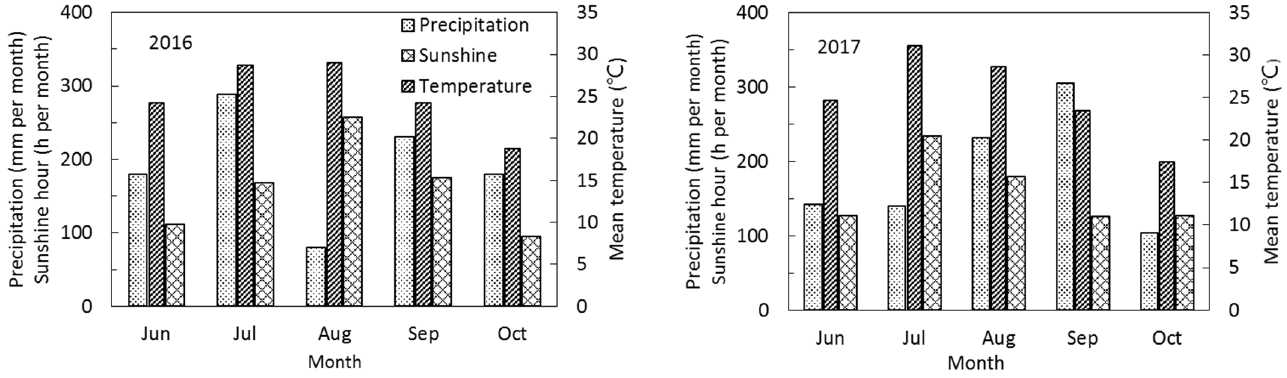
Figure 1. Precipitation, sunshine hours and temperature during the rice growing season of 2016 and 2017 in Jiangyan, Southeast China. The precipitation and sunshine hours are monthly totals. The temperatures are the monthly averages.